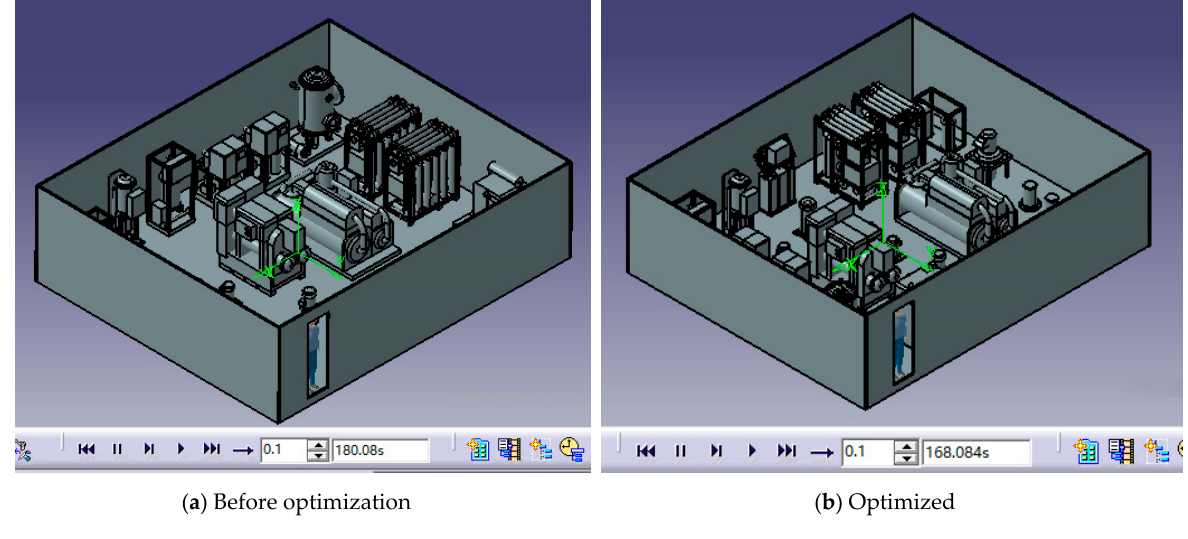
Figure 9. Simulation